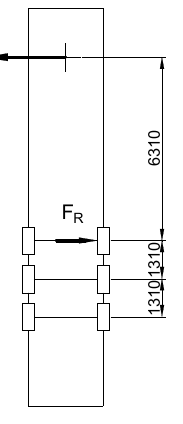
Figure 3. The scheme of the trailer